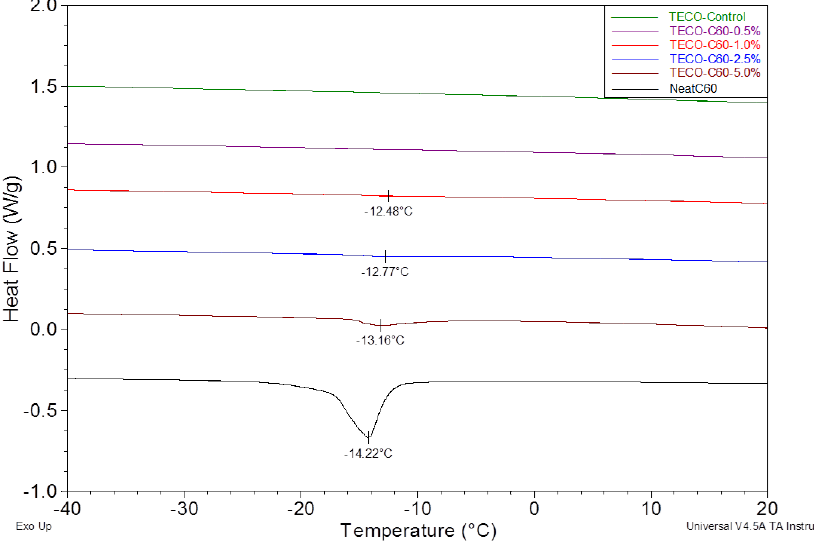
and neat C 60 60